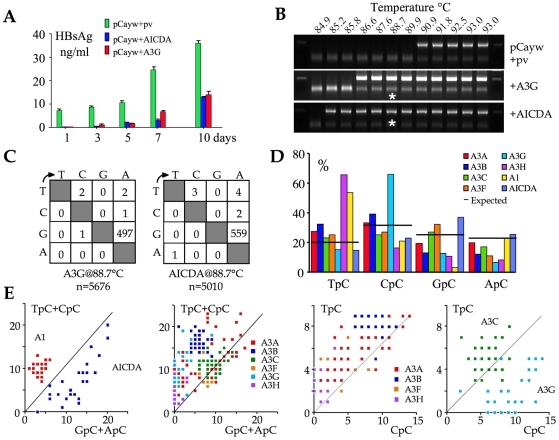
AICDA impacts HBV replication by hyperediting the genome.A) Macroscopic impact of AICDA and A3G on HBsAg secretion into the culture supernatant following transfection of the infectious molecular clone, pCayw. B) 3DPCR recovered A3G- and AICDA-edited HBV genomes down to 86.6°C and 85.2°C respectively. pv: empty plasmid vector and HBV alone. Asterisks refer to the samples cloned and sequenced. C) Mutation matrices for hyperedited X gene sequences derived from cloned 88.7°C 3DPCR products. n indicates the number of bases sequenced. D) Bulk dinucleotide context of HBV X region minus strand DNA by eight human cytidine deaminases. E) Clonal analysis of editing for individual edited sequences. The number of TpC+CpC vs. GpC+ApC targets edited per sequence are computed and represented on the y and x axes respectively. As the A3C and A3G genes were strongly up regulated (Figure 1) they have been separated from the others. Clonal analysis using TpC vs. CpC allows clear isolation of A3G from other A3 enzymes.